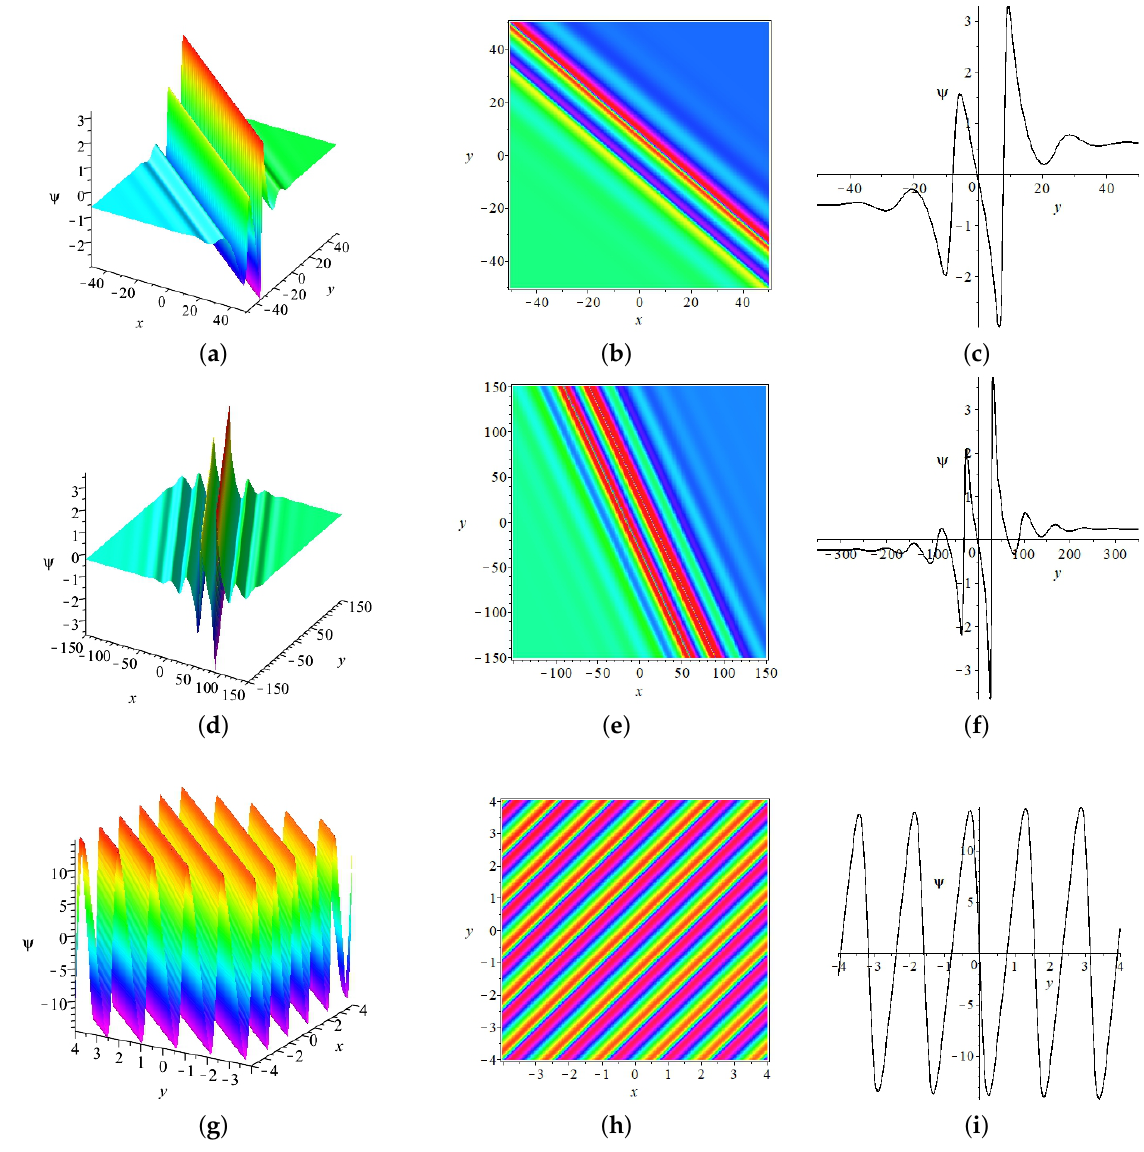
Figure 4. (Color online) The transformation of one-breather with r 2 = r 3 = r 4 = r 6 = r 7 = r 8 = 1, β 1 = 2, γ 1 = 0, κ 1 = 0. In ( a ), a 1 = 0.1, b 1 = 0.3, c 1 = 1.2, d 1 = 0, e 1 = 0.1, f 1 = − 3.5. In ( d ), a 1 = 0.04, b 1 = 0.2, c 1 = 0.5, d 1 = 0, e 1 = − 0.01, f 1 = 1. In ( g ), a 1 = 0.004, b 1 = 4, c 1 = − 1, d 1 = 0, e 1 = 0.01, f 1 = − 5. These three figures are three-dimensional stereograms when t = 0, z = 0. ( b , e , h ) are the corresponding contour figure. ( c , f , i ) show the wave moves along the y axis when x = 0, t = 0, z =